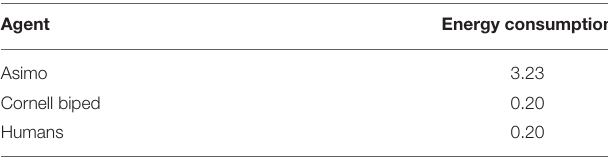
TABLE 1 | Energy consumed during legged locomotion (Collins et al., 2005). Unit weight per unit